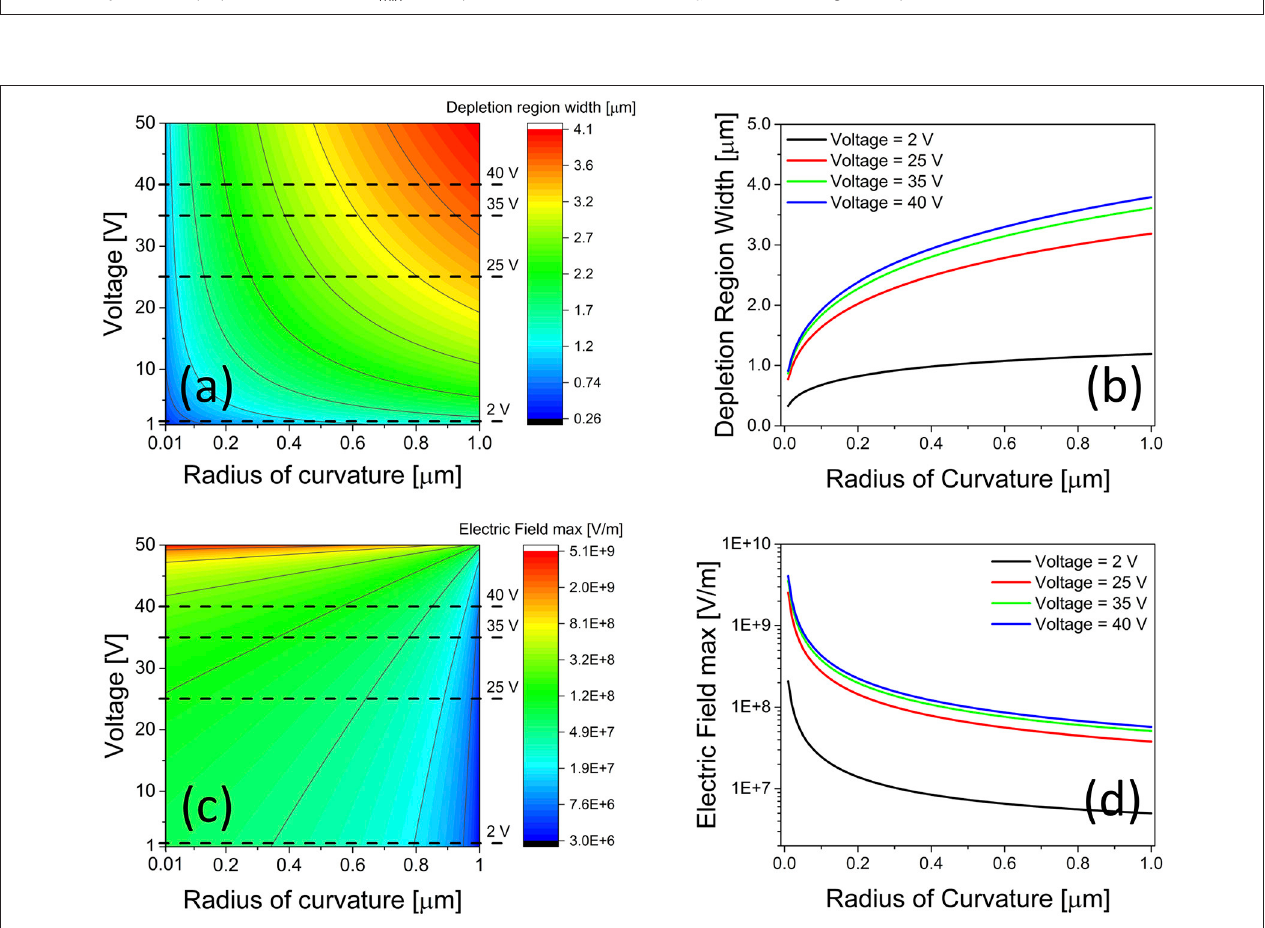
FIGURE 3 | Theoretical results on depletion region width and maximum electric-field intensity at the electrolyte/silicon interface of a pore, as a function of both anodic voltage and curvature radius values. (a,c) Contour plot of depletion region width w d and maximum intensity of electric-field E max in the silicon substrate as a function of electrolyte/silicon interface anodic voltage and curvature radius; (b,d) depletion region width w d and maximum intensity of electric-field E max in the silicon substrate as a function of electrolyte/silicon interface curvature radius, for different anodic voltage values, namely 2, 25, 35, and 40V, corresponding to dashed lines in (a,b) .